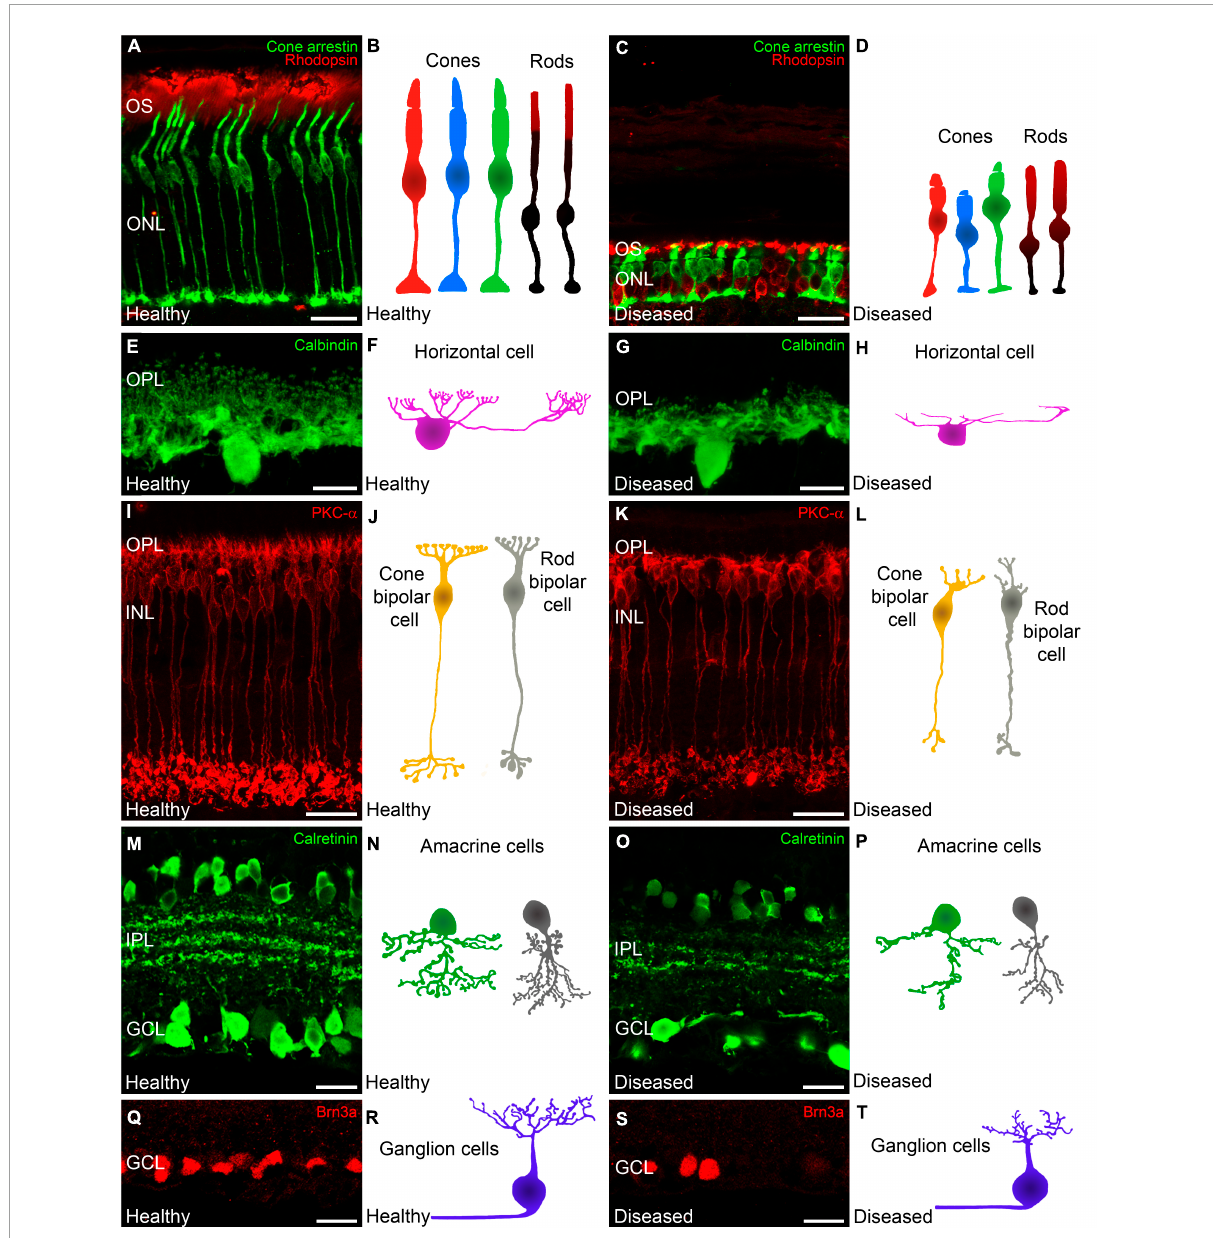
FIGURE4 Changes in photoreceptors and inner retinal neurons during retinal degeneration. Retinal cross-sections immunostained with different retinal cell markers followed by a schematic drawing of each cell in a healthy mouse retina and in a retina from an IRD model. Photoreceptors (A,C) immunolabeled against cone arrestin (cone cells in green) and rhodopsin (outer segments of rods, red). (A,B) Normal morphology of cones and outer segments of rod photoreceptors. (C,D) In IRD affected retinas, cones show shortened and swollen outer and inner segments as well and a reduced axon length. Moreover, rods display an abnormal distribution of rhodopsin. (E,G) Horizontal cells immunostained against calbindin. (E,F) Normal morphology of horizontal cells showing the tips of the terminal branches from their axons and dendrites. (G,H) In IRD affected retinas, horizontal cells show shortened dendrites and axons accompanied with loss of synaptic terminals. (I,K) ON rod bipolar cells immunostained against PKC α . (I) Shows the normal morphology of ON rod bipolar cells whereas (K) shows retraction of bipolar cell dendrites and axons in IRD conditions. (J,L) Schematic representations of cone and rod bipolar cells in healthy (J) and diseased (L) conditions. (M,O) Calretinin immunostaining showing subpopulations of amacrine and ganglion cells as well as 3 immunoreactive plexuses in the IPL. (M) Shows the normal cell density and plexus structure and (O) Shows the loss of amacrine and ganglion cells with degeneration together with the loss of dendrites and synaptic contacts in the IPL. (N,P) Schematic depictions of representative amacrine cells in healthy conditions (N) and affected by retinal degeneration (P) . (Q,S) Brn3a immunostaining to allow the identification of retinal ganglion cell somata. Normal ganglion cell density in healthy retinas (Q) and ganglion cell loss in IRD affected retinas (S) . (R,T) Schematic depiction of normal ganglion cell morphology in healthy retinas (R) and dendritic alterations in diseased retinas (T) . OS: outer segment; ONL: outer nuclear layer; OPL: outer plexiform layer; INL: inner nuclear layer; GCL: ganglion cell layer. Scale bars: 20 µ m (A,C,I,K,M,O,Q,S) ; 10 µ m (E,G)